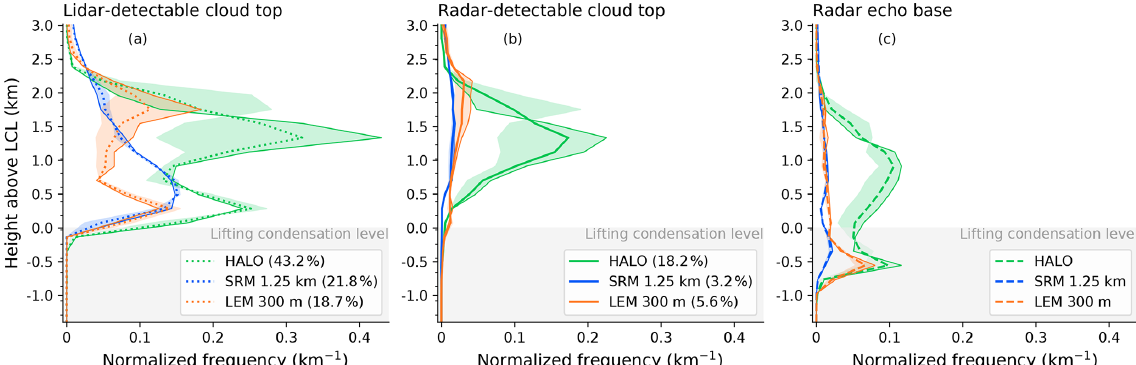
Figure 5. Cloud boundary statistics on all observed and forward-simulated lidar and radar signals: (a) lidar cloud top, (b) radar cloud top, and (c) radar echo base. The same thresholds for cloud detection are used for the observed and simulated lidar and radar signals. Height is in relation to the lifting condensation level (LCL). Shadings depict the western (bright edge) and eastern (dark edge) half of each dataset. The histogram bin edges are depicted as ticks on the y axis. Total shallow 2D cloud coverage detected by lidar and radar in each dataset are given in the legends. This total cloud coverage can be derived from a cumulative version of this figure presented in Fig.